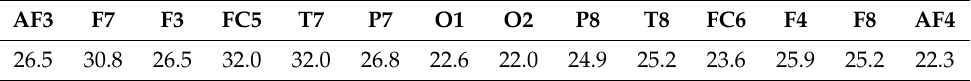
Table 4. EERs (%) when introducing SVM and